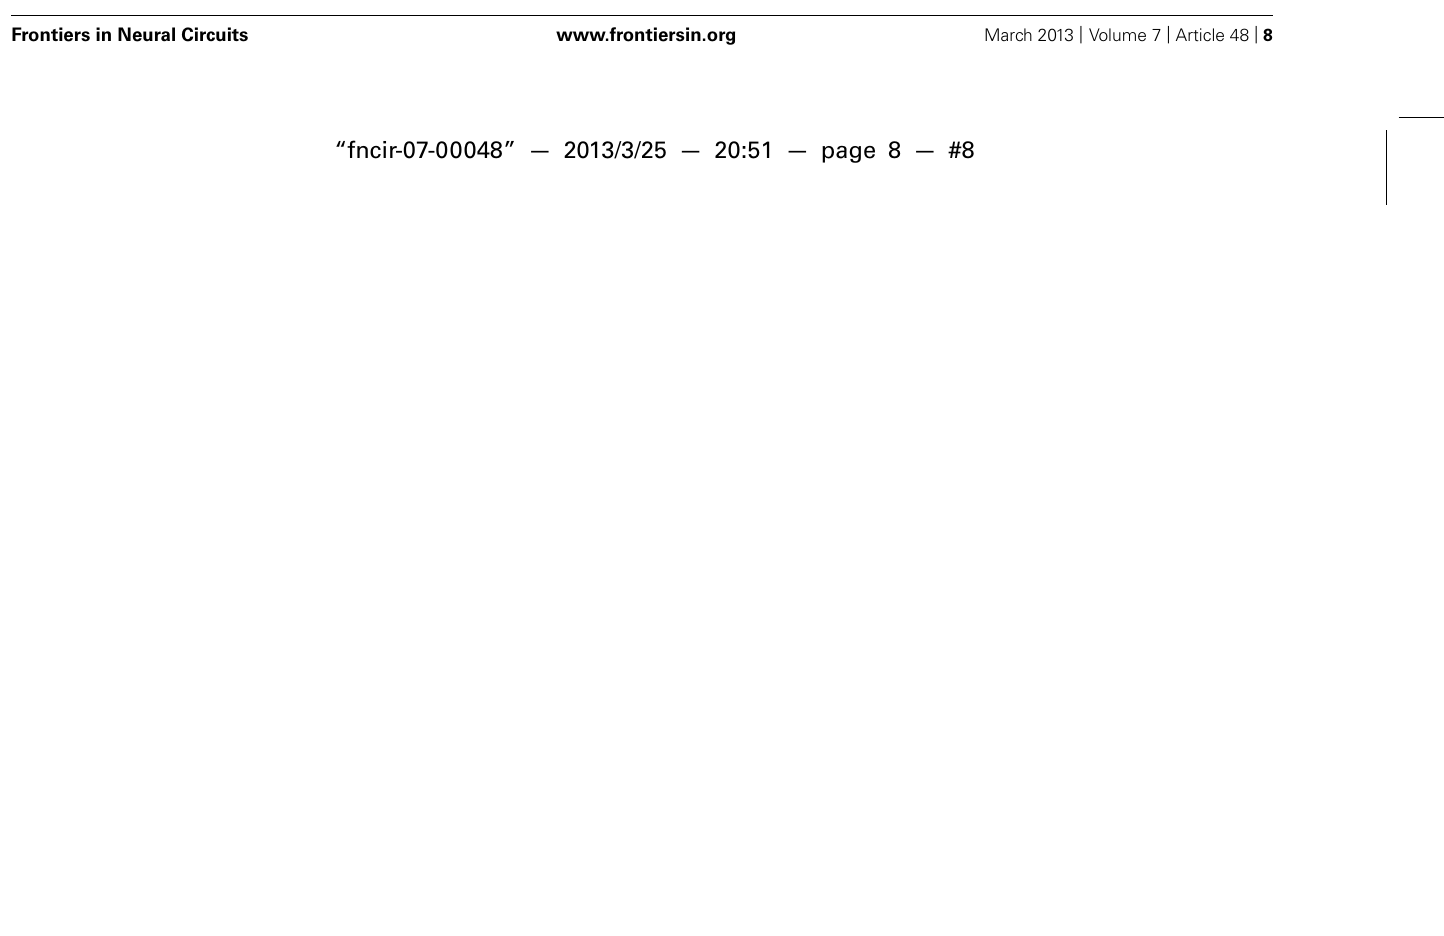
The numbers correspond to the p -value for each combination. (A) Peak amplitude vs peak latency maps. (B) Comparison between peak amplitude maps of different components.The results for SG and PG are